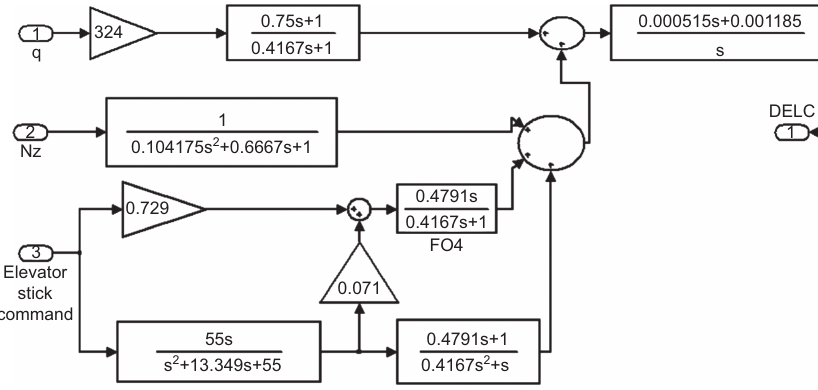
Figure 2. Simulink Model of C-Star Controller.